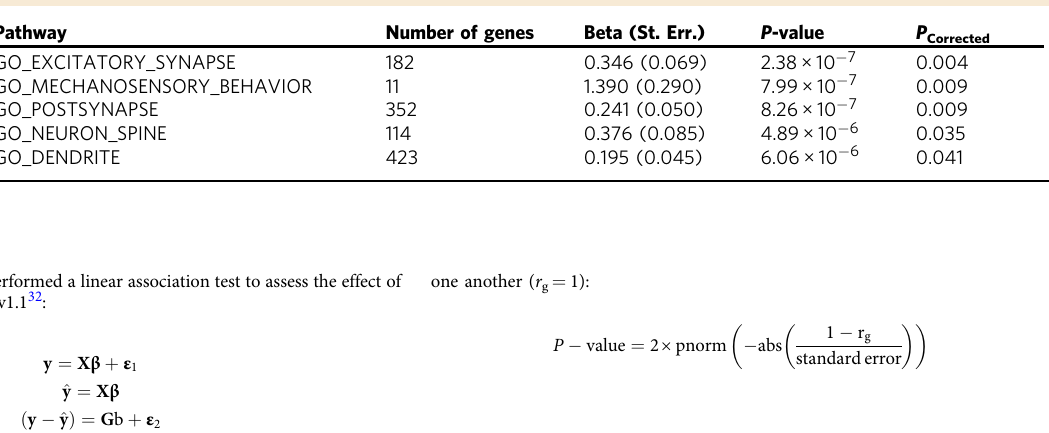
Table 2 Pathways with a signi fi cant effect ( P corrected < 0.05) on broad depression following multiple testing correction identi fi